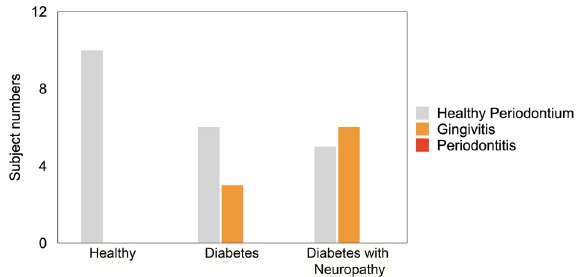
Figure 1. Periodontal profiles among the groups. PSR category-0: Healthy Periodontium, PSR-1: Gingivitis, PSR-2: Periodontitis. Chi-square test, p < 0.05.